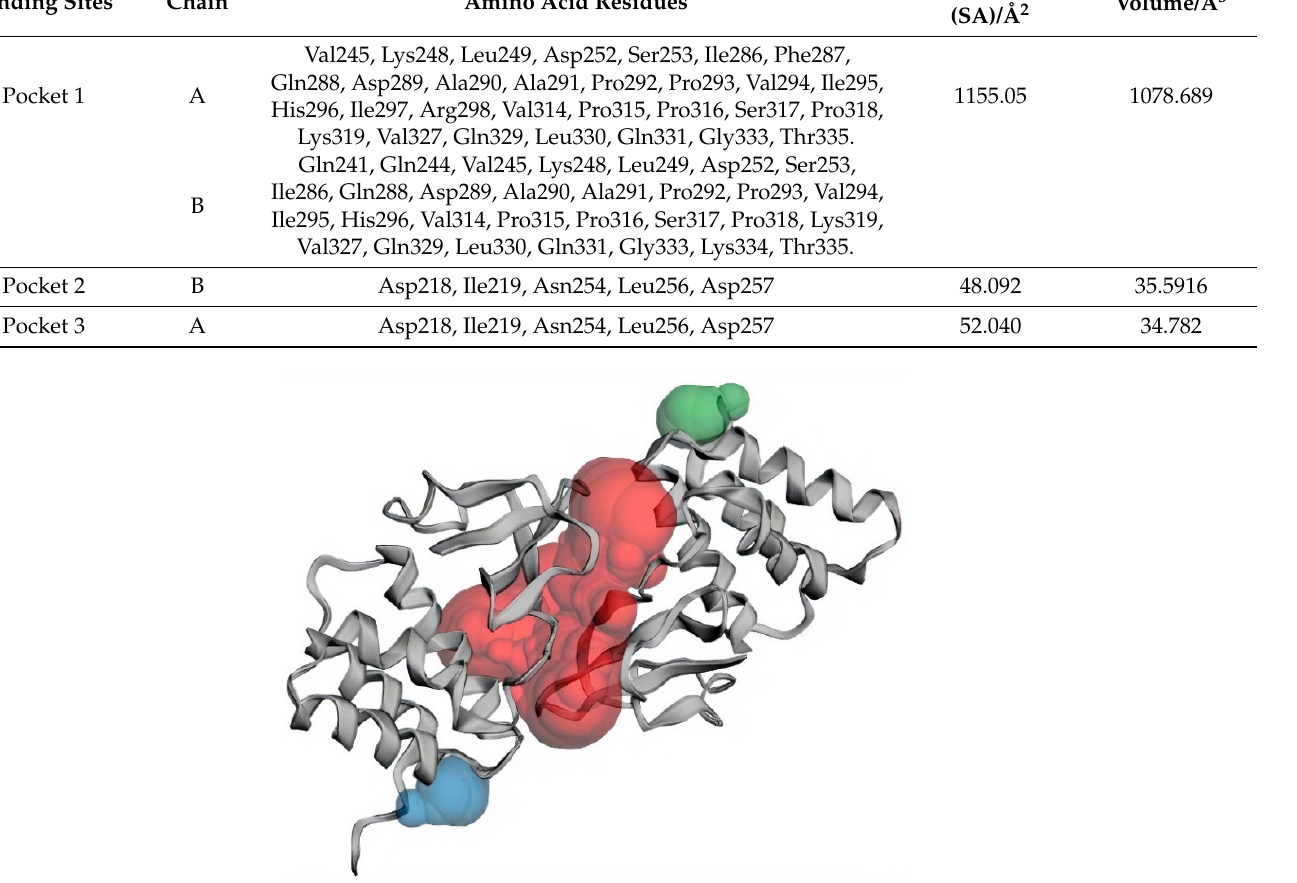
Figure 2. Three major binding pockets of EBOV VP35 predicted via CASTp, with large surface areas and volumes. The red, blue and green colors represent pockets 1, 2 and 3, respectively. Table 1. Major binding sites of EBOV VP35 predicted using CASTp and the amino acid residues within each binding pocket. SA: Solvent accessible.